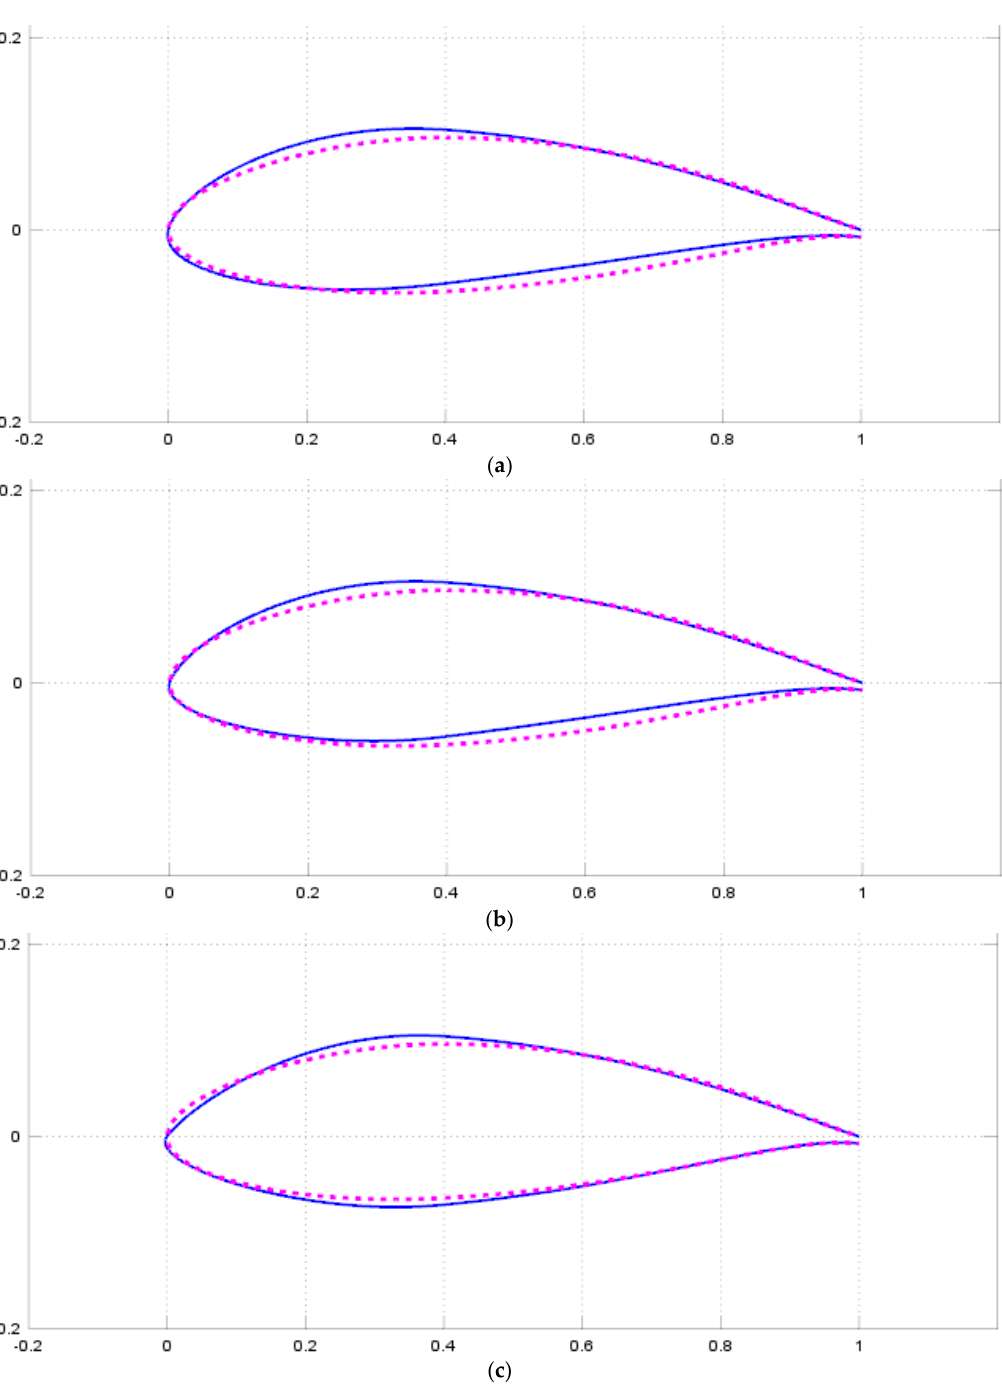
Figure 11. Optimized airfoil shapes for L/C = 6, for the points indicated by empty arrows in Figure 9 ( a ) Point 1; ( b ) Point 2; ( c ) Point 3 (Figure 8), red dotted line: original, blue solid line: optimized (note that vertical scale is larger than horizontal scale).